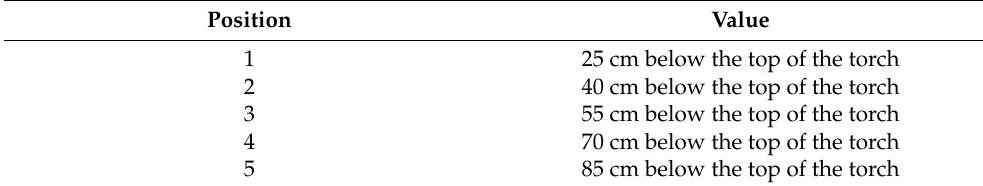
Table 2. Description of measurement